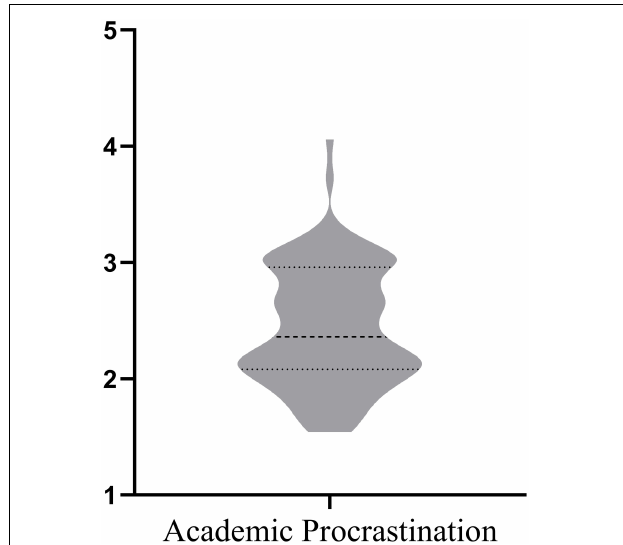
FIGURE 1 | Overview of academic procrastination.